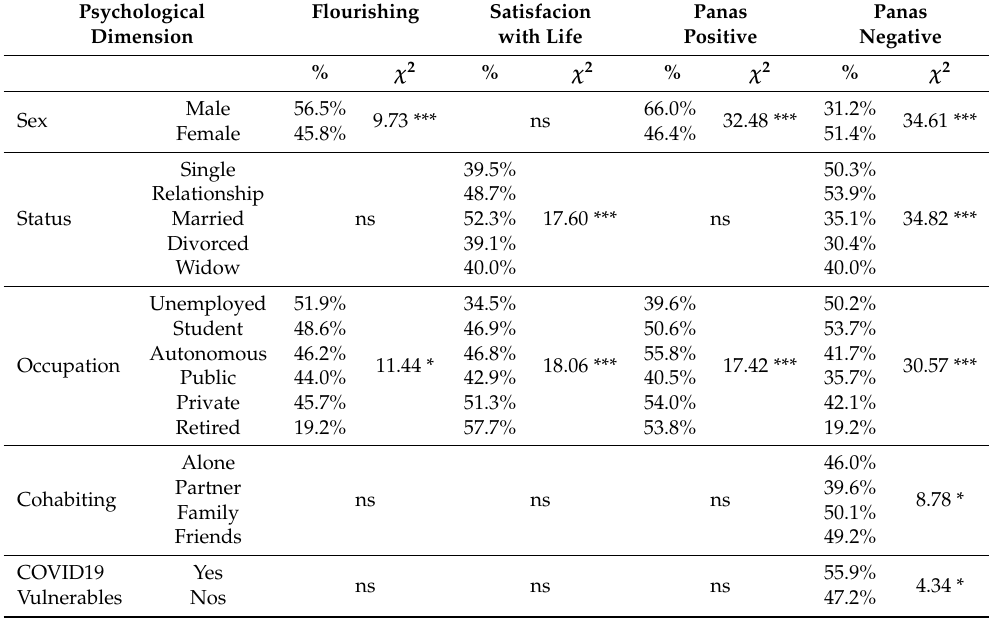
Table 4. Relations between well being with discrete socio-demographic and COVID-19 related variables. For the sake of simplicity, we only reported the percentages of observations that were characterized by a greater value than the